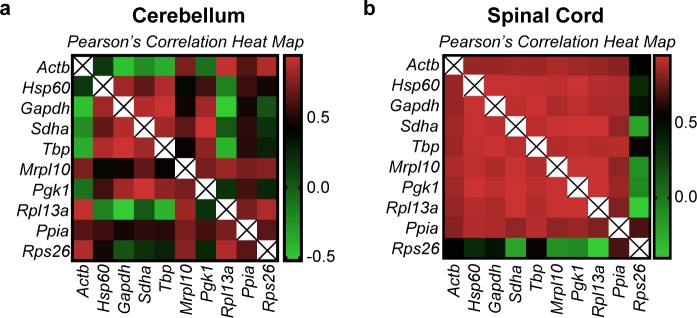
Pearson’s correlation heatmap of the linearized Cq values (2-Cq) of all genes.Pearson’s correlation of all genes was performed to identify the extent of expression correlation in (a) cerebellum and (b) spinal cord. The colour scheme is denoted next to each heatmap. The numerical values used in the colour scheme represent the Pearson’s r score. r = 0 (no correlation), r = +0.5 (positive correlation), r = -0.5 (negative correlation). r values closer to +1 or -1 denote strong positive and negative correlations respectively. The diagonal lines marked with an “X” are indicative of the correlation of a gene with itself and therefore is omitted from analysis.